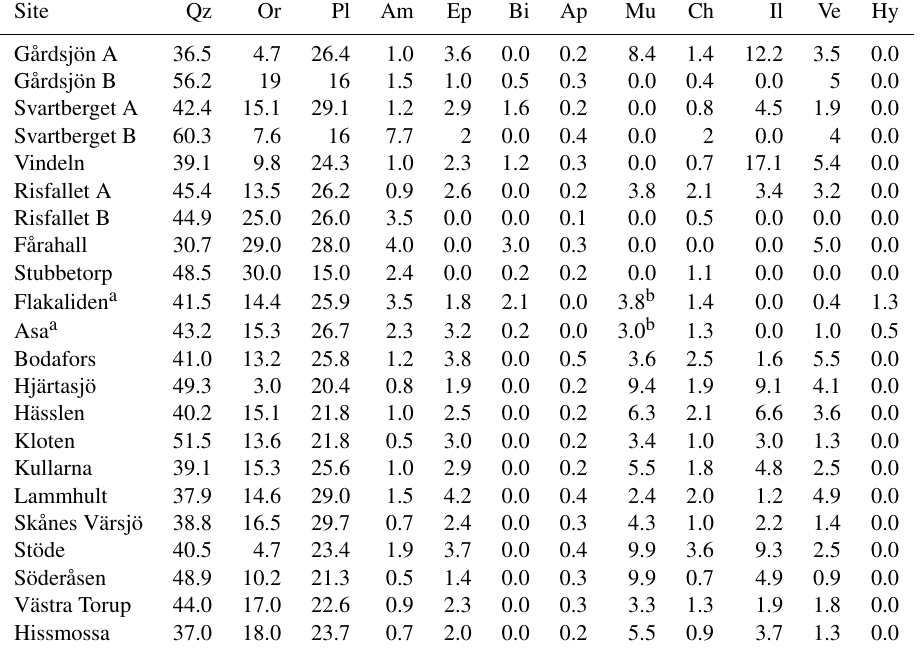
Table 2. Mineral content in soil at 50cm depth (weight%) used as input for modelling weathering rates for the different sites: Qz (quartz), Or (orthoclase), Pl (plagioclase), Am (amphibole), Ep (epidote). Bi (biotite), Ap (Apatite), Mu (Muscovite), Ch (chlorite), Il (illite), Ve (vermiculite), and Hy (hydrobiotite). Minerals occurring in very small amounts, with minor effect of weathering rates, are not included in the table. Input data were not found for Gårdsjön C. The mineralogy has in some cases been slightly simplified to make it fit in one table. For detailed mineralogy, see original references (Table